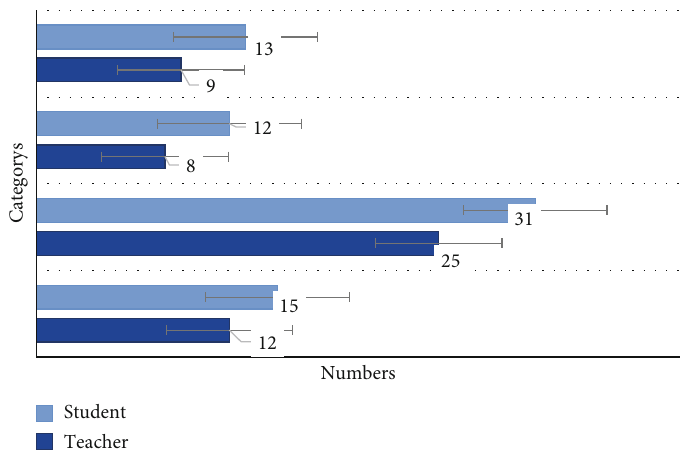
Figure 4: Performance analysis of Taekwondo teaching system in colleges and universities based on D M